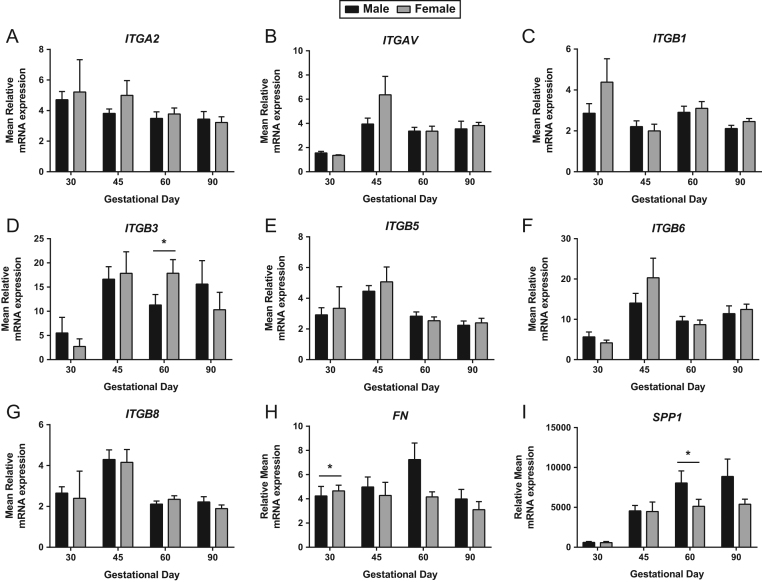
Integrin mRNA expression in endometrial tissues associated with male and female foetuses on days 30, 45, 60 and 90 of pregnancy. mRNA expression of ITGA2 (A), ITGAV (B), ITGB1 (C), ITGB3 (D), ITGB5 (E), ITGB6 (F), ITGB8 (G), FN (H) and SPP1 (I) in endometrial samples associated with male and female foetuses at GD30, 45, 60 and 90. Error bars represent s.e.m. *P ≤ 0.05. n = 3–16 foetuses/GD.